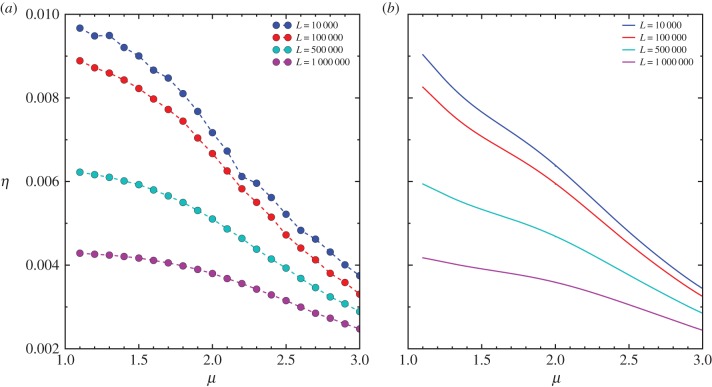
(a) The search efficiency η versus the power-law exponent μ for different values of the threshold moving distance  from numerical simulation with the intensity of stochastic returning β = 0, the landscape size L = 1000, the number of targets K = 5000 and the termination condition  where  is the accumulated moving distance. The results are averaged over 100 realizations. (b) η evaluated by the mean-field solution by setting the total number of steps N by  in equation (3.3).